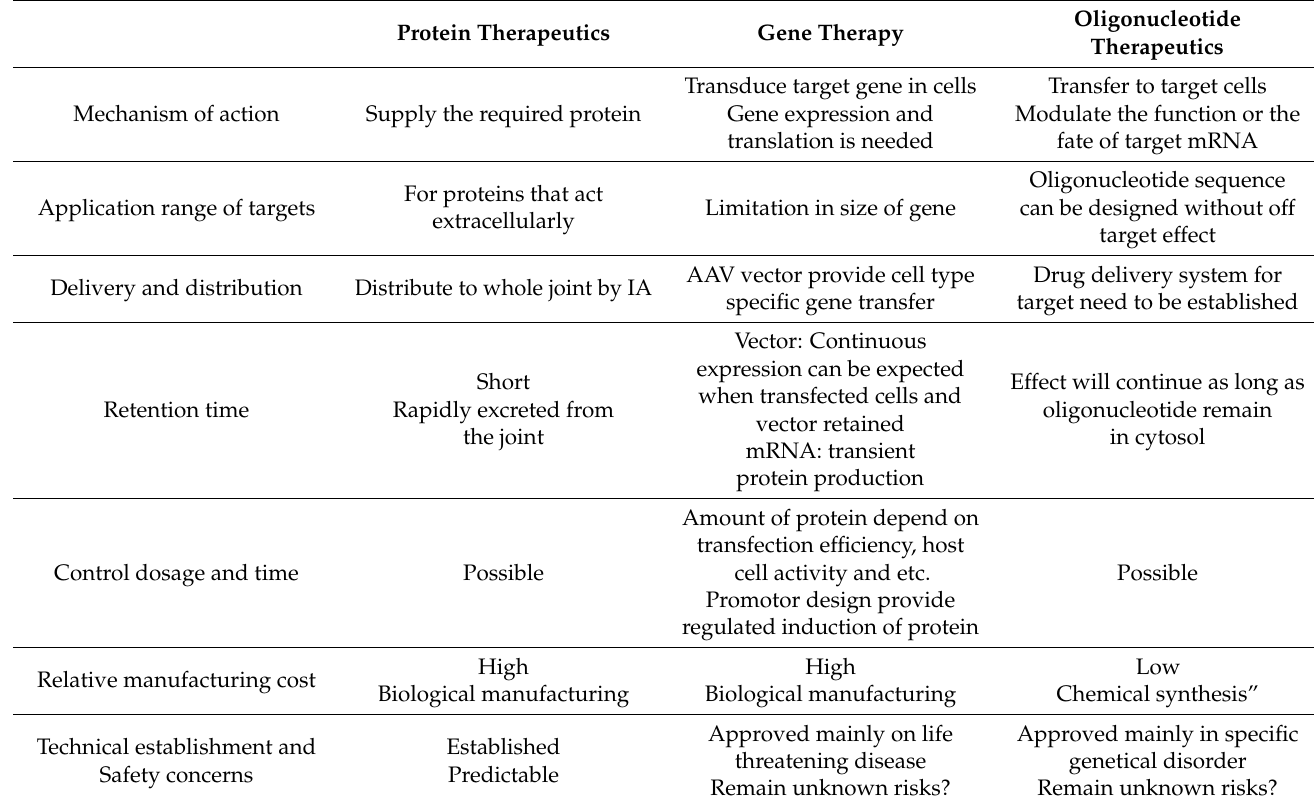
Table 5. Summary of new approaches for disease-modifying osteoarthritis drugs